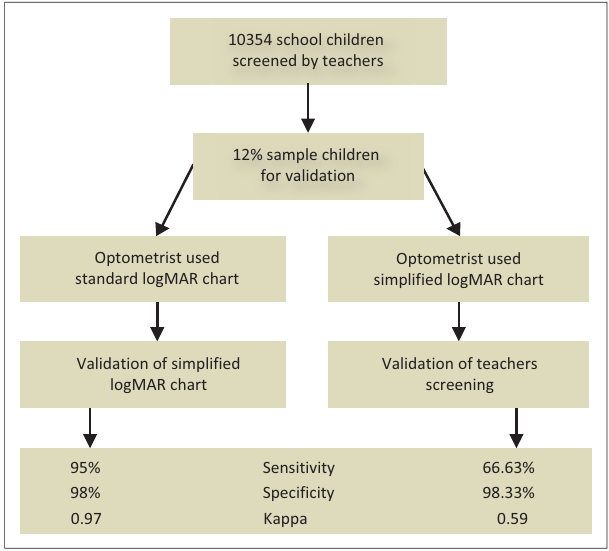
FIGURE 4: Validation of screening